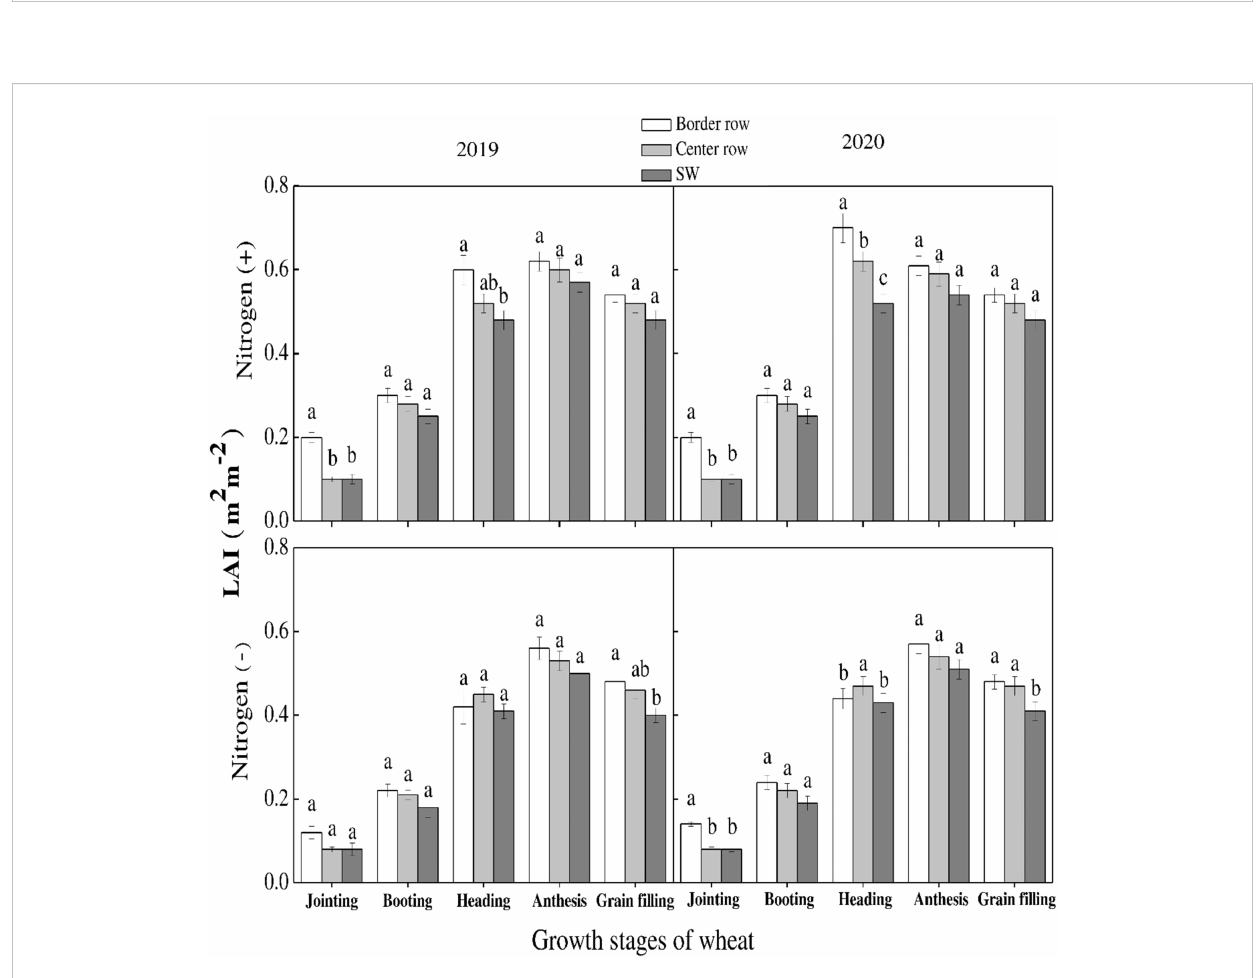
FIGURE 6 Leaf area index (LAI) of the border-, center- and sole wheat (SW) crop at various growth stages under with- and without N application. Different letters on the top of each bar indicate signi fi cant differences among the various crop growth stages, as calculated by Tukey ’ s HSD test at P ≤ 0.05.